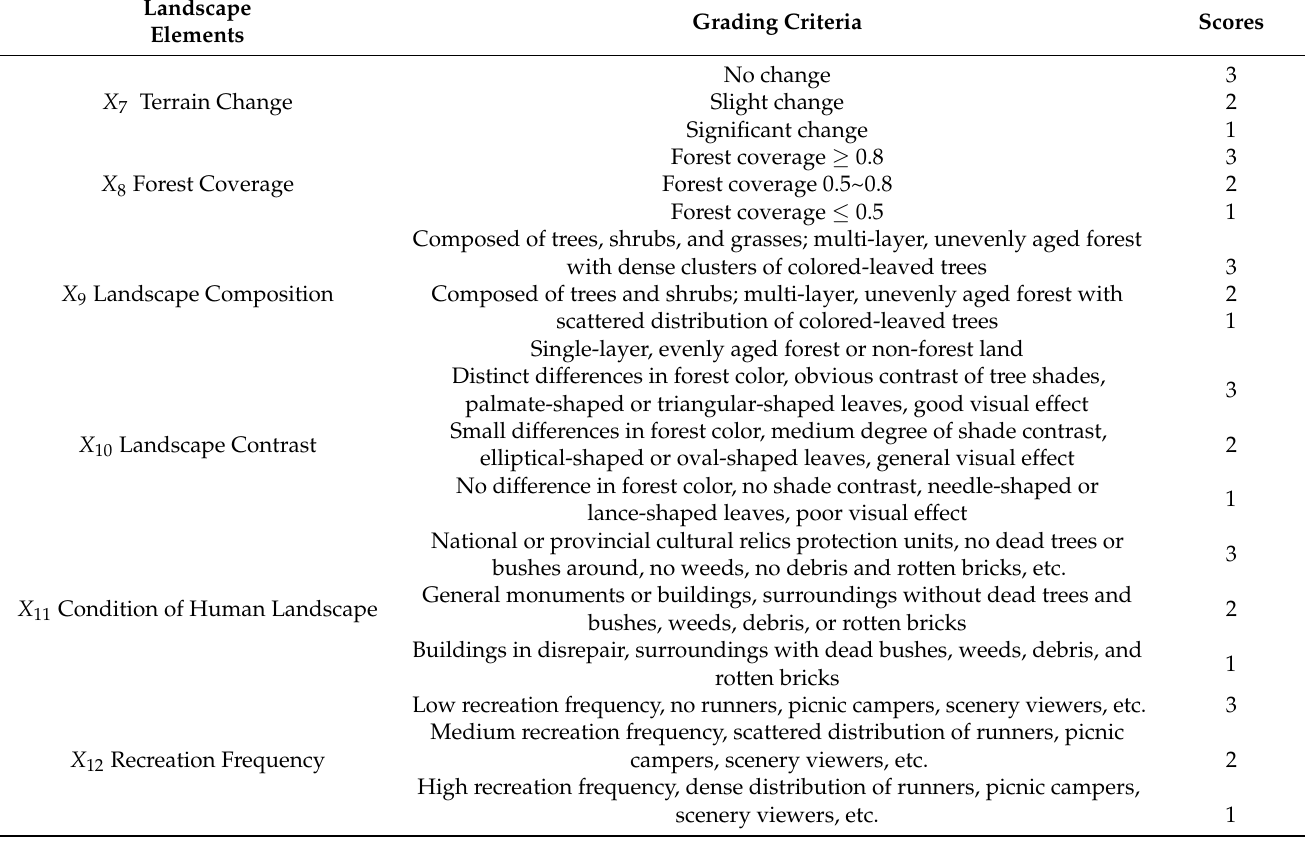
Table 4. Landscape elements and grading criteria for the aerial observation